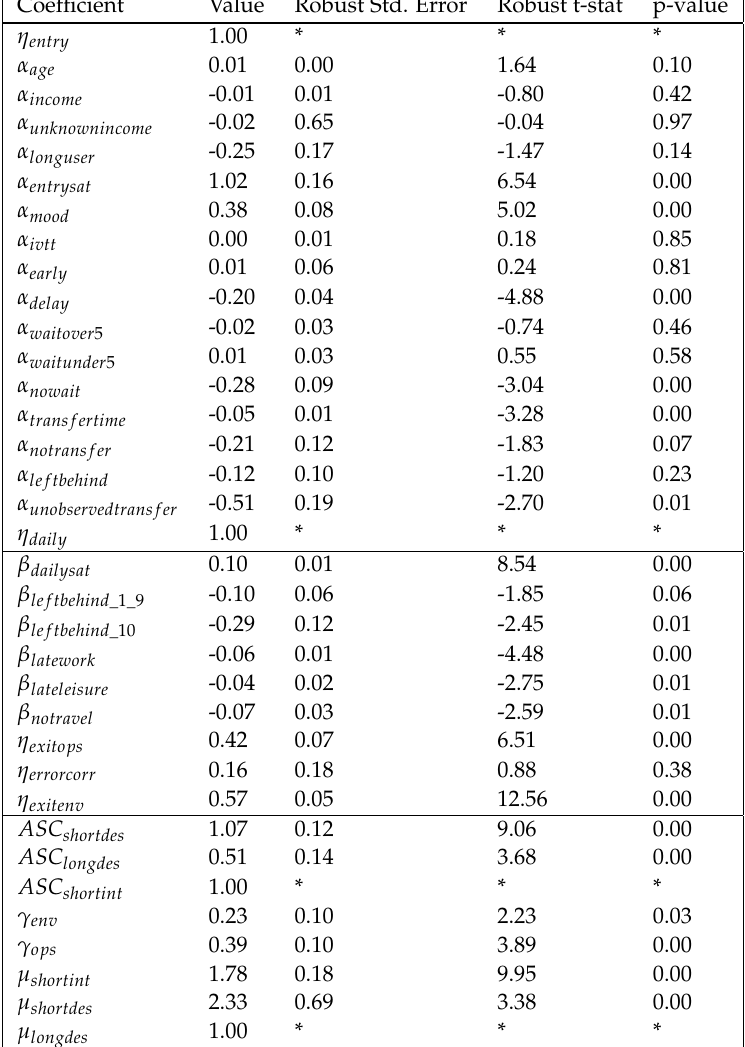
Table 3. Estimation results for the structural equations of the latent variable choice model. Coefficient Value Robust Std. Error Robust t-stat